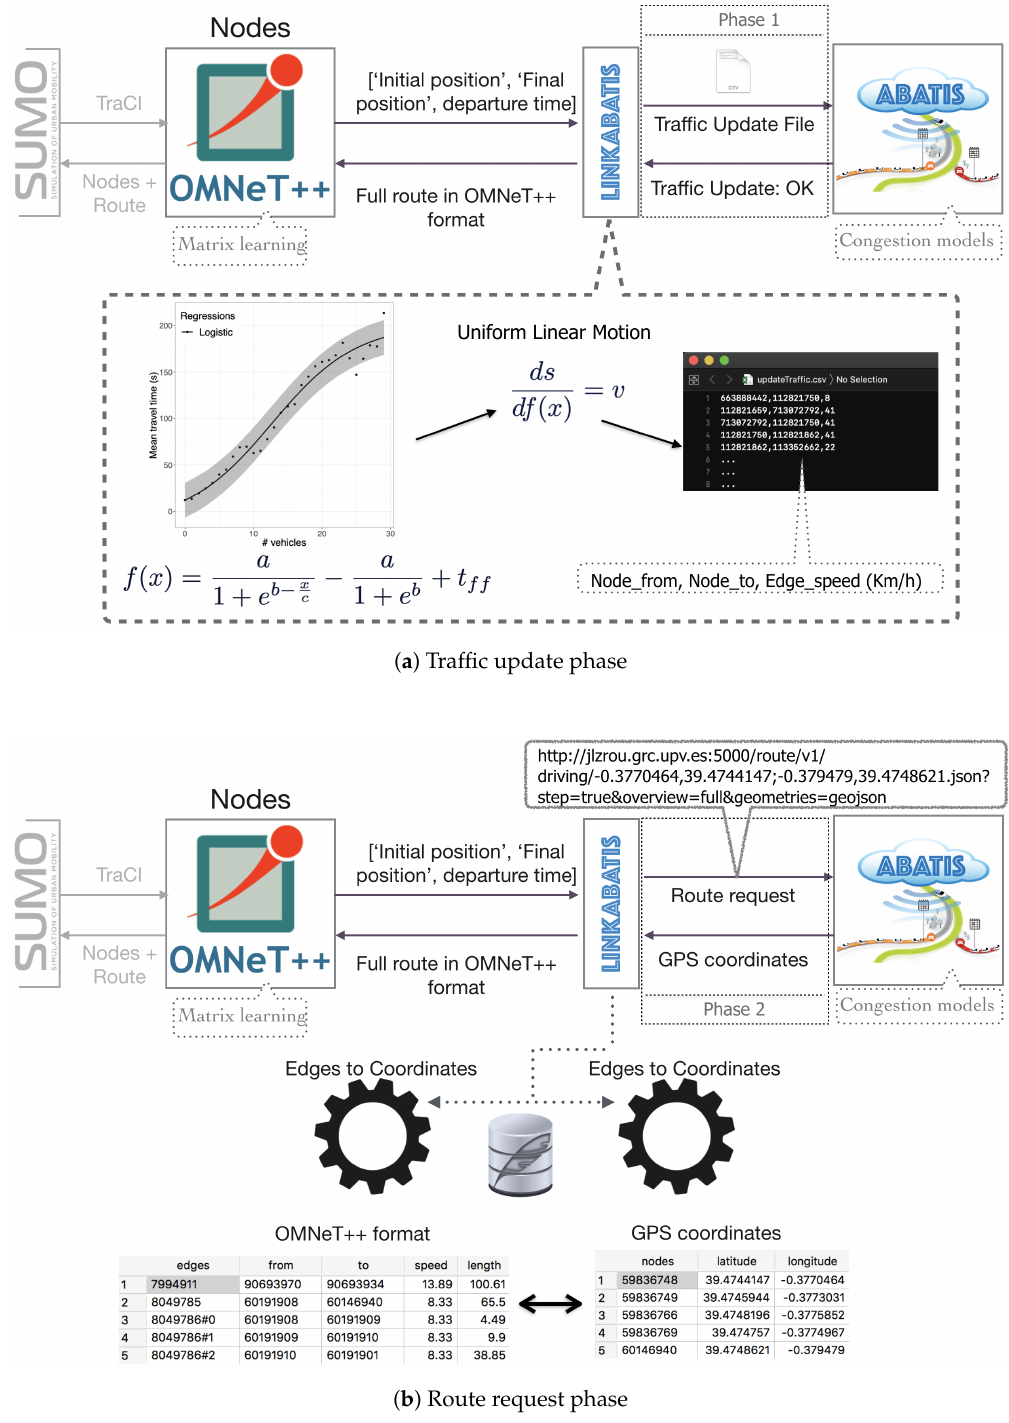
Figure 2. The different phases associated with our smart